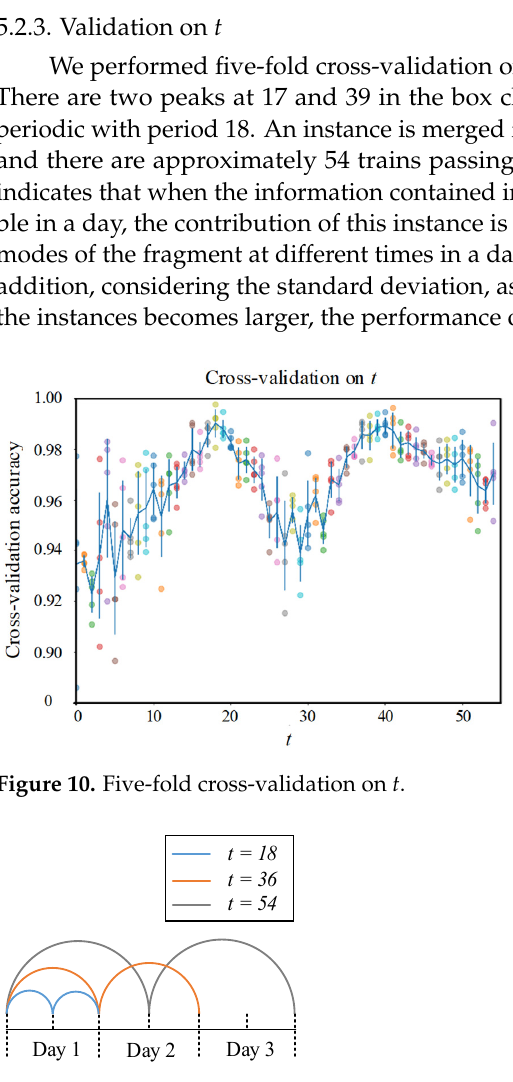
Figure 11. A description of how hyper-parameter t works.